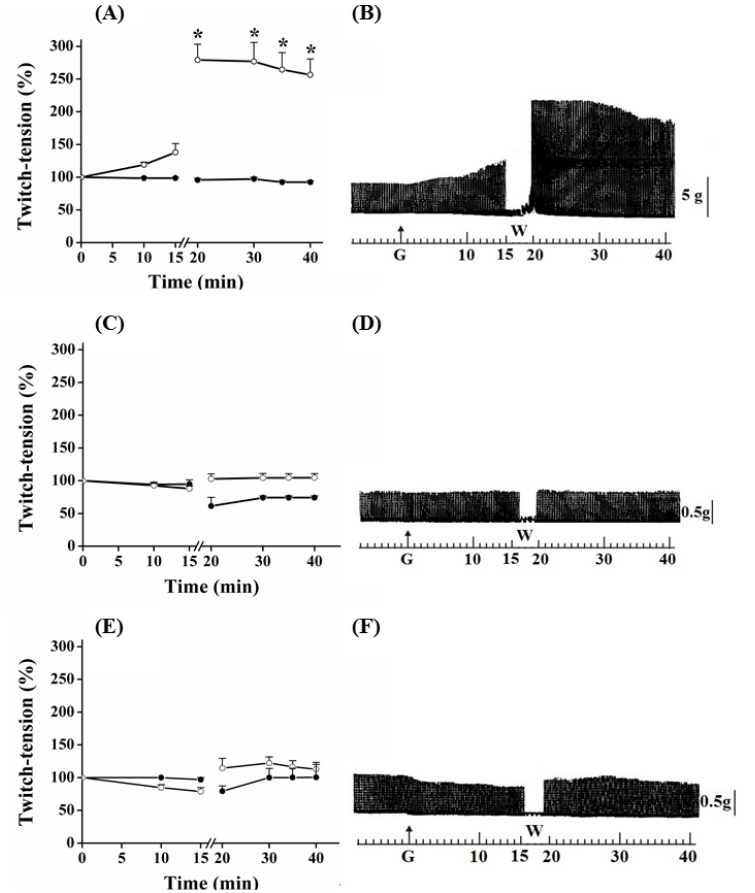
Figure 1. Effect of guanidine (10 mM) (white circles) for 15 min on the twitch response of PND (A), EDL (C) and SOL (E) (n = 8/each) in comparison with matched controls (black circles) (n = 3, 8, 8, respectively). The line breaking corresponds to the preparation washing (W). Each point represents the mean ± S.E.M; one-way ANOVA followed by Tukey test, * P ≤ 0.05. Panels B (PND), D (EDL) and F (SOL) display the myographic isometric twitch record of preparations incubated with guanidine (G). The vertical bars (5, 0.5 g) represent muscle